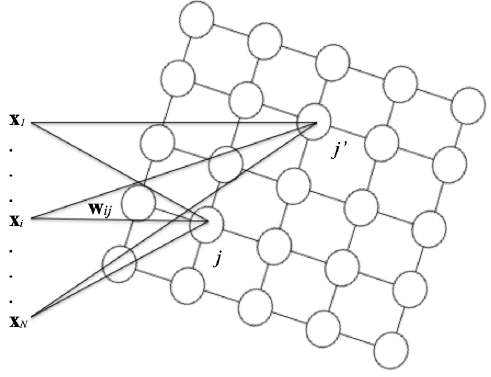
5 Kohonen neural network Figure 3. A 5 × 5 Kohonen neural ×